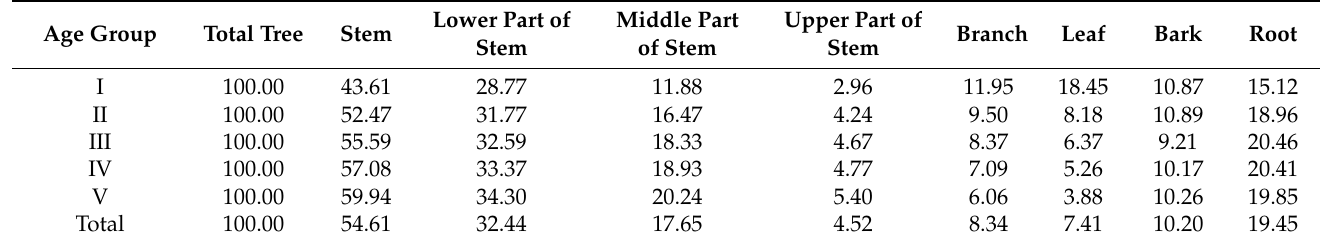
Table 3. Proportion (%) of biomass of various organs in different age groups of Chinese fir.